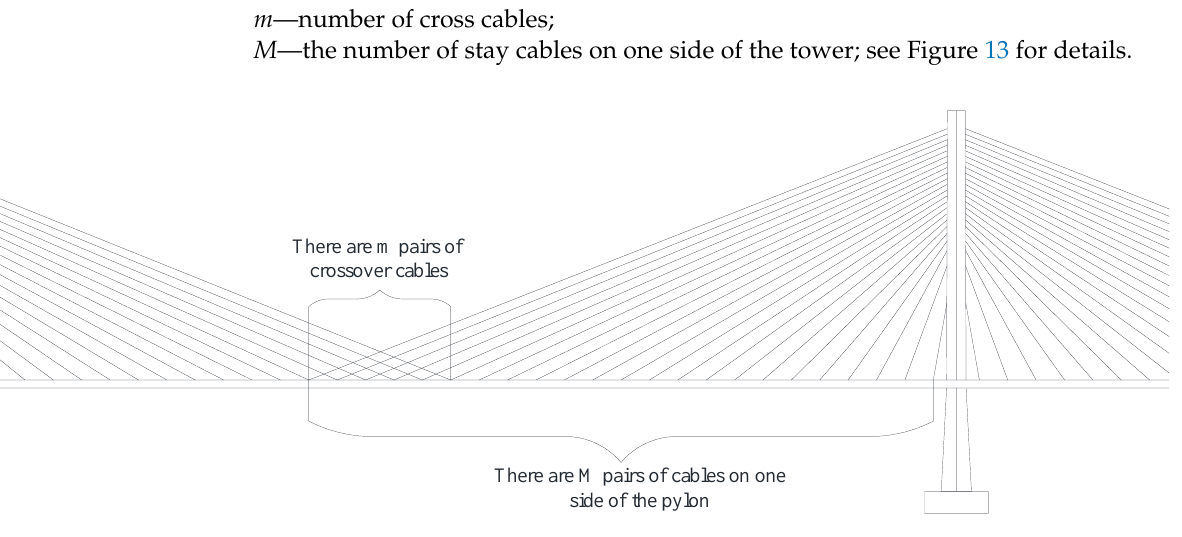
Figure 13. Cross-cable ratio calculation diagram.